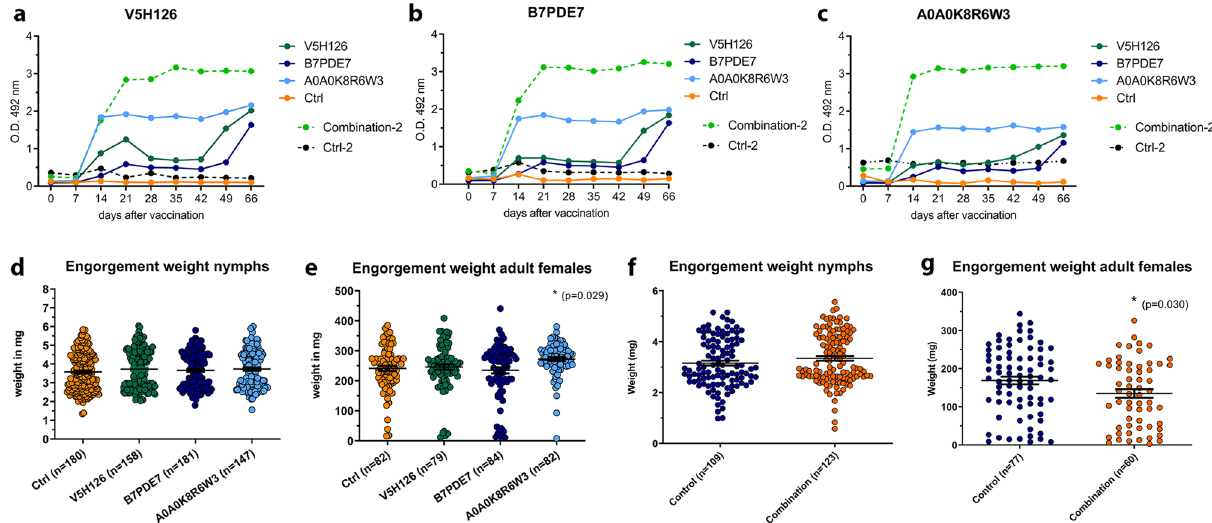
Figure 4. The effect of vaccination on tick feeding in cows. ( a – c ) Antigen specific total IgG reactivity for both cow vaccination experiments as measured by ELISA coated with V5H126, B7PDE7 and A0A0K8R6W3 respectively. The second experiment with the combined vaccination and the control group is indicated with suffix -2 and shown with dashed lines. ( d , e ) Tick engorgement weights after single antigen vaccinations for nymphs and adults respectively. The number of engorged nymphs was significantly reduced for V5H126 and A0A0K8R6W3 (P < 0.01 and P < 0.0001, Chi-Square). Statistical differences in engorgement weights as measured by one-way ANOVA is indicated by * ( f , g ) Tick engorgement weights after combined antigen vaccinations for nymphs and adults respectively. Total number of collected engorged ticks are indicated in brackets for each experimental group and was significantly reduced (P < 0.01 Chi-Square). Lines indicated means and error bars depict Standard Error of the Mean. Statistical differences as measured by Mann Whitney test is indicated by *.